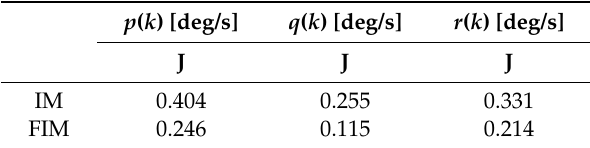
Figure 5. The measured q ( k ) signal and the time varying upper bounds ( ) q k and lower bounds ( ) q k derived for the IM applying Equation (18) and for the FIM applying Equation (20).